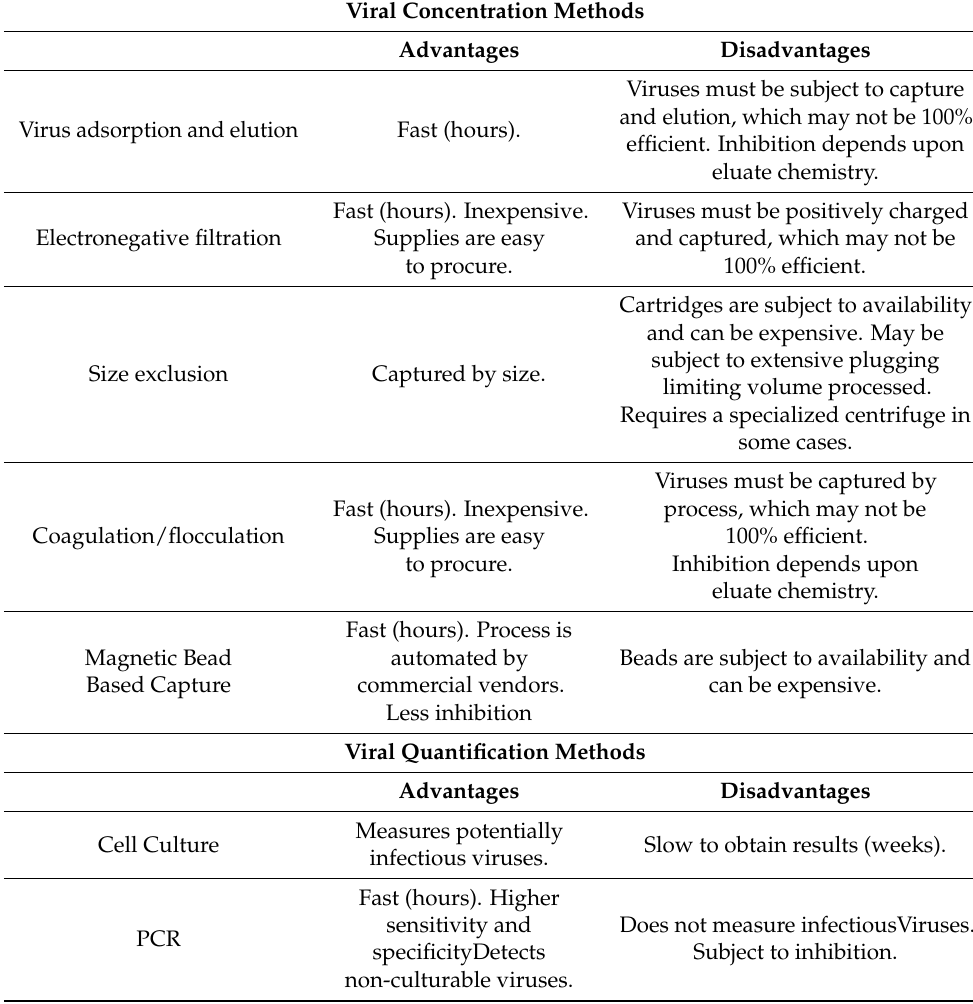
Table 1. Methods for Concentrating and Quantifying Viruses in Wastewater